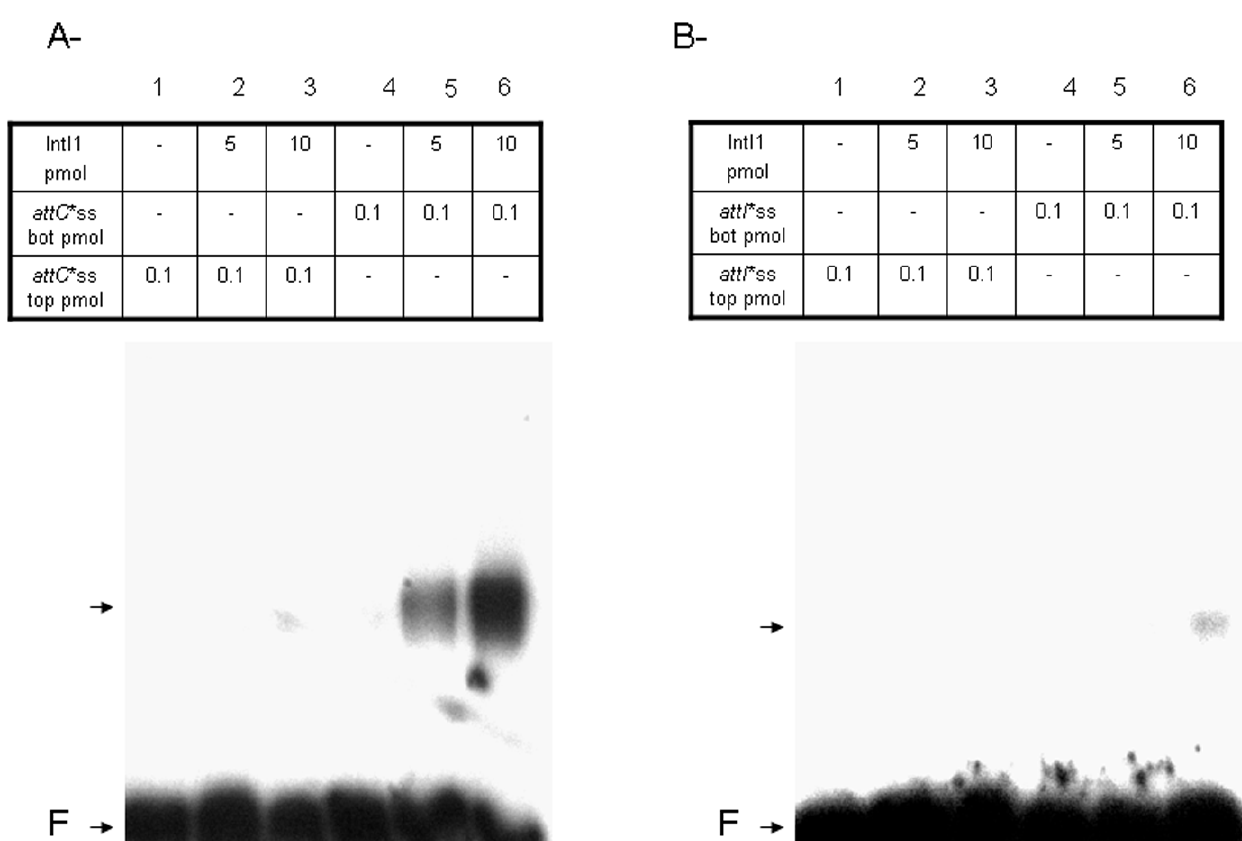
Figure 4. InvitroDNA binding of IntI1 with free single-stranded attC(A) and attI(B) recombination sites. Free 5 9 32 P radiolabeled ssDNA fragments containing recombination sites (0.1 pmoles) were incubated with purified IntI1 (5–10 pmoles) at 4 u C for 20 min before electrophoresis on